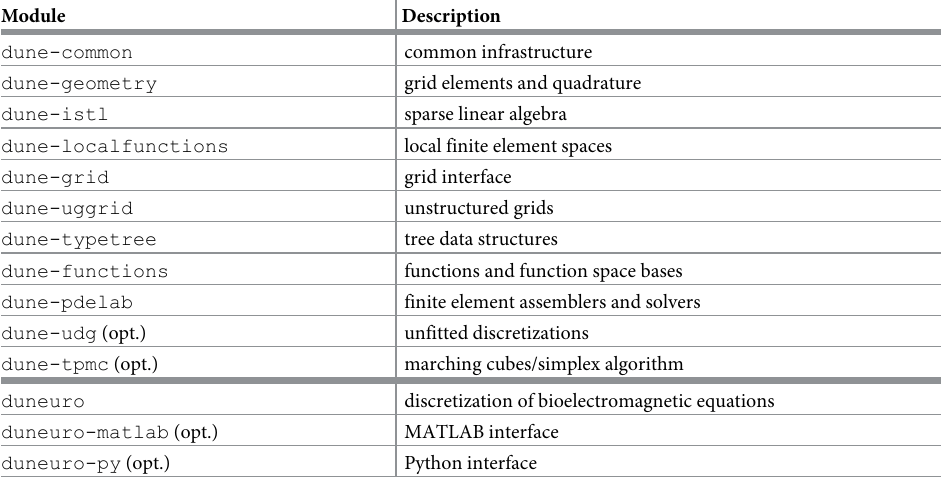
Table 2. Overview of DUNE and DUNEuro